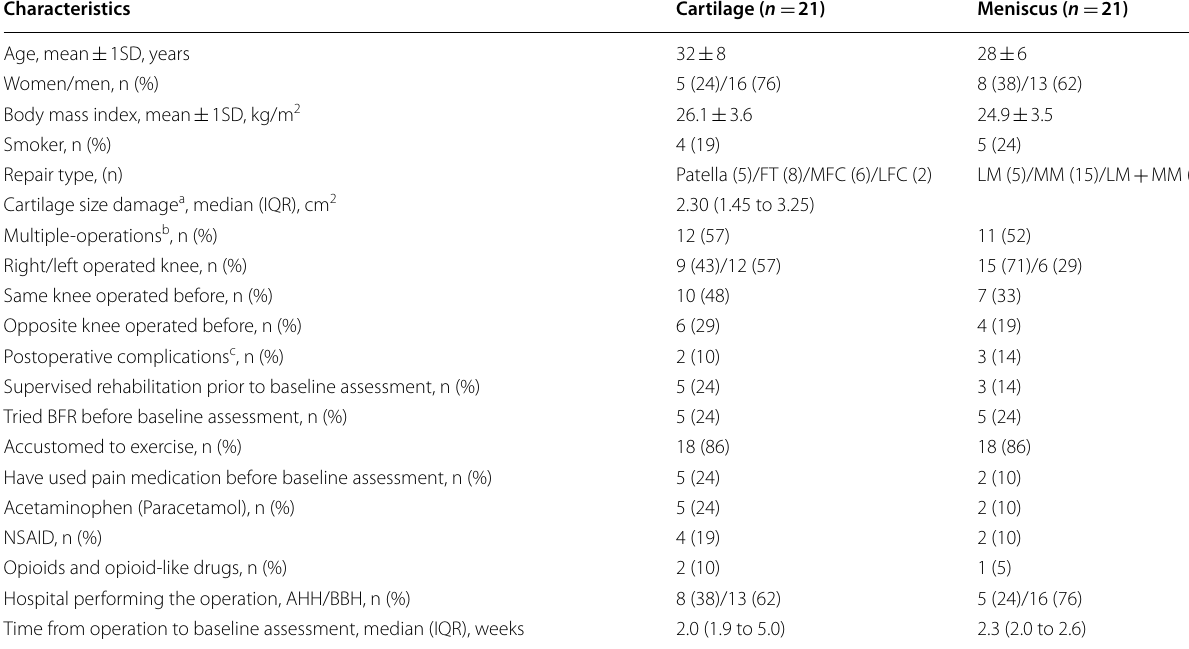
Table 2 Baseline characteristics for the patients with cartilage or meniscus repair